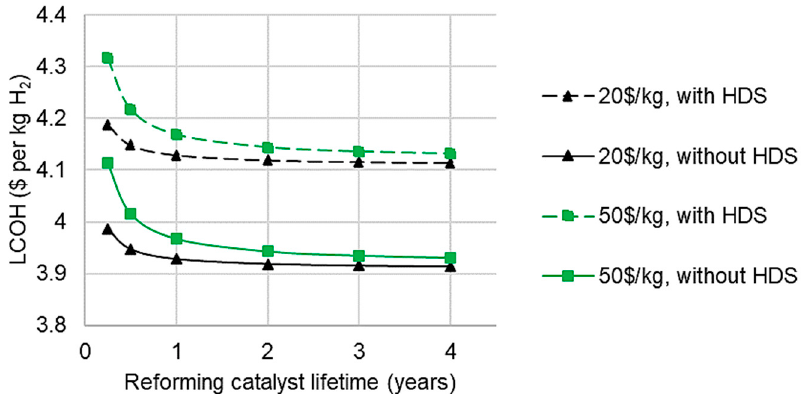
Figure 10. Effect of catalyst lifetime, cost, and hydrodesulphurisation on levelised cost of hydrogen from C-SR, 10,000 Nm 3 h − 1 .